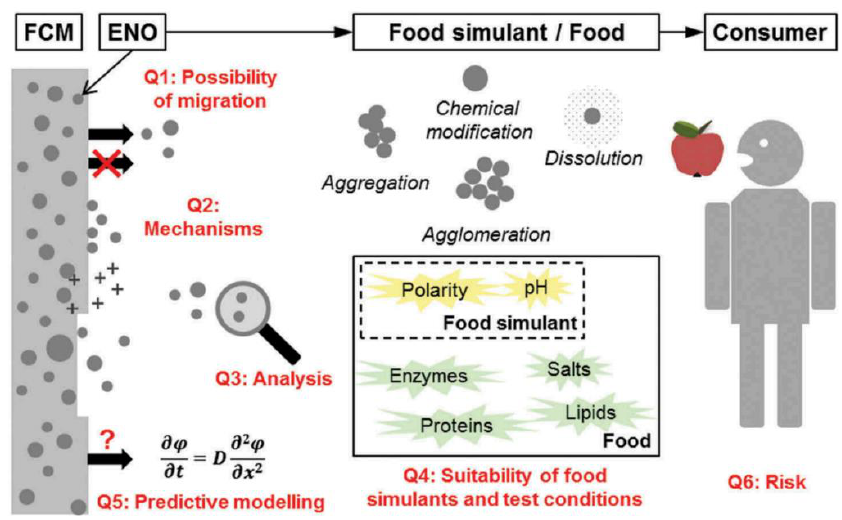
Figure 2. Overview of the six open questions about the migration of NPs from polymer-based food-contact materials identified in Jokar et al.’s review (FCM = food-contact materials, ENO = engineered nano-objects) [166].